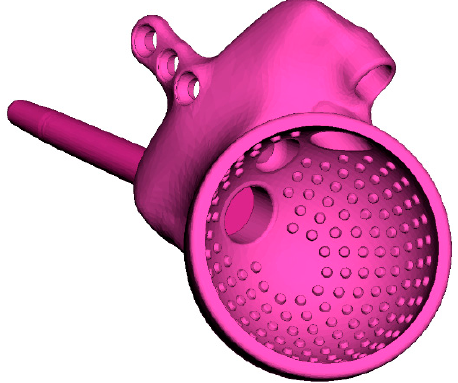
Figure 4. Geometric model of customised endoprosthesis